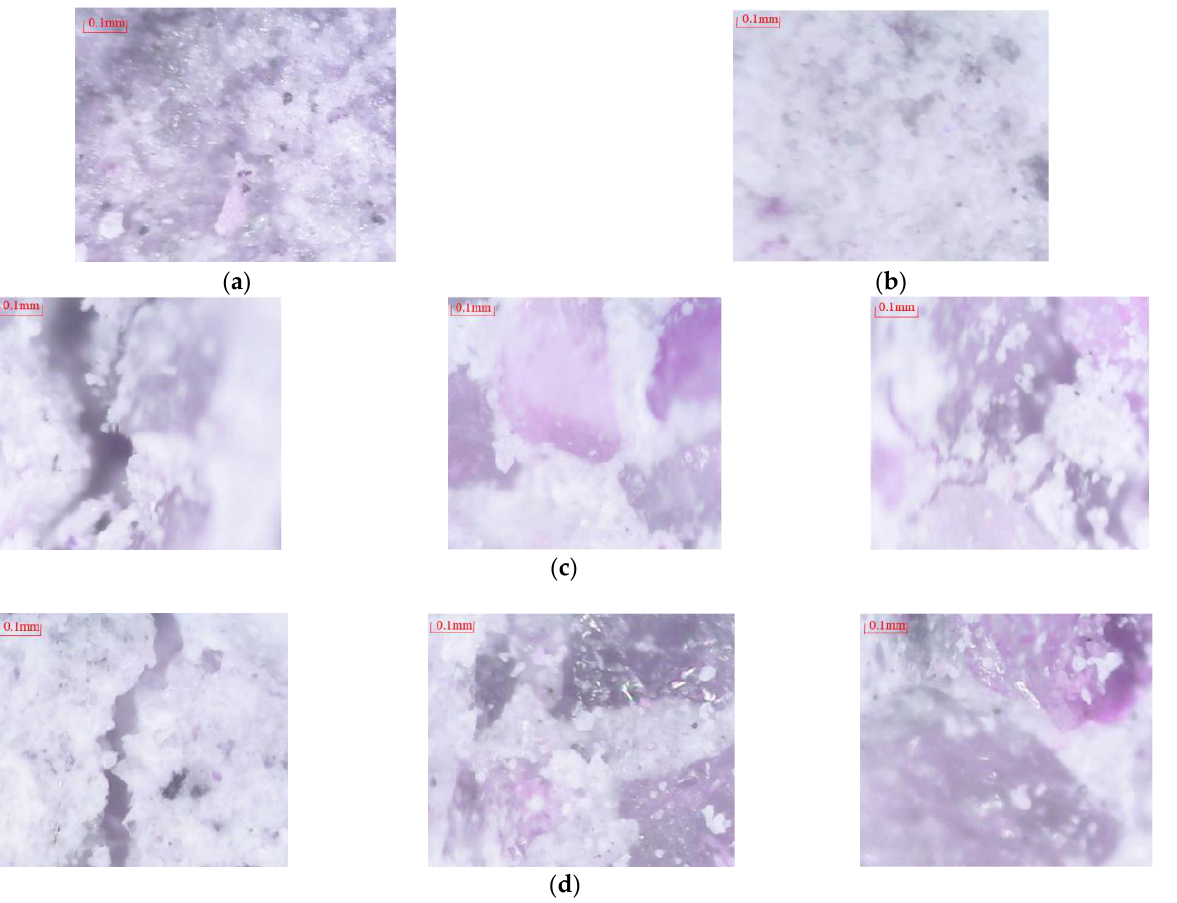
Figure 10. Microscopic fracture morphology of similar materials. ( a ) Microscopic view of the surface of a mudstone-like specimen. ( b ) Surface micro-view map of a sandstone-like specimen. ( c ) Mesoscopic fracture morphology of mudstone-like specimens. ( d ) Micro-fracture morphology of sandstone-like specimens.